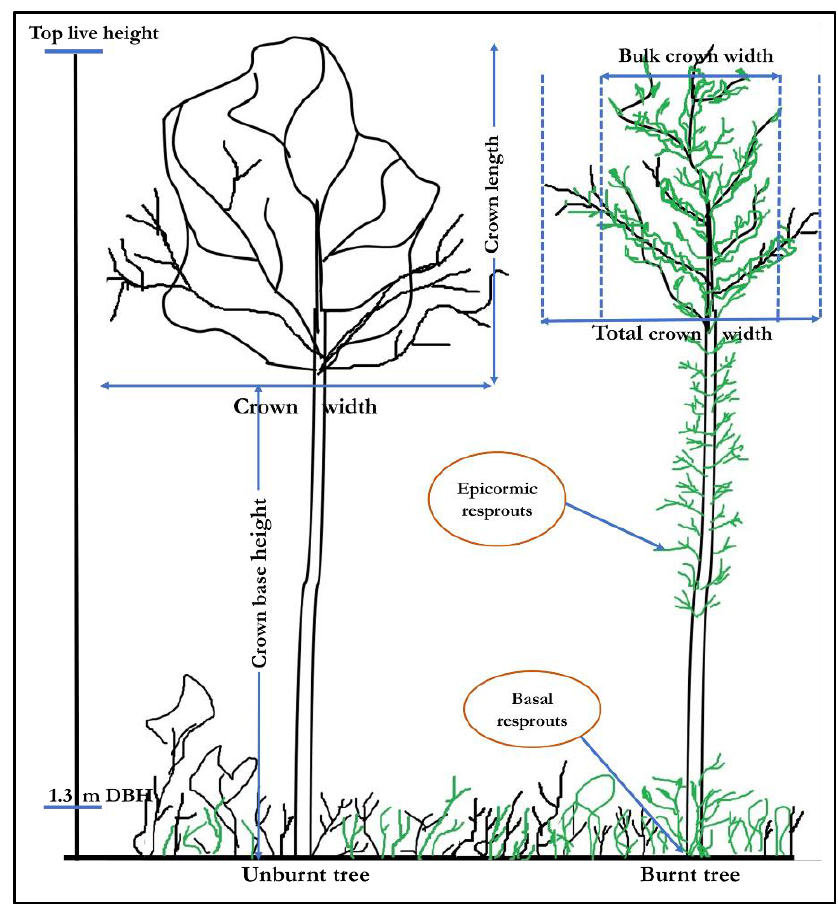
Figure 2. Field measurements of unburnt and severely burnt trees, including tree height metrics, crown-width metrics (bulk crown width of the live crown, total crown width to outermost extremities, which could be dead) and the presence/absence of epicormic (stem) and basal resprouts.